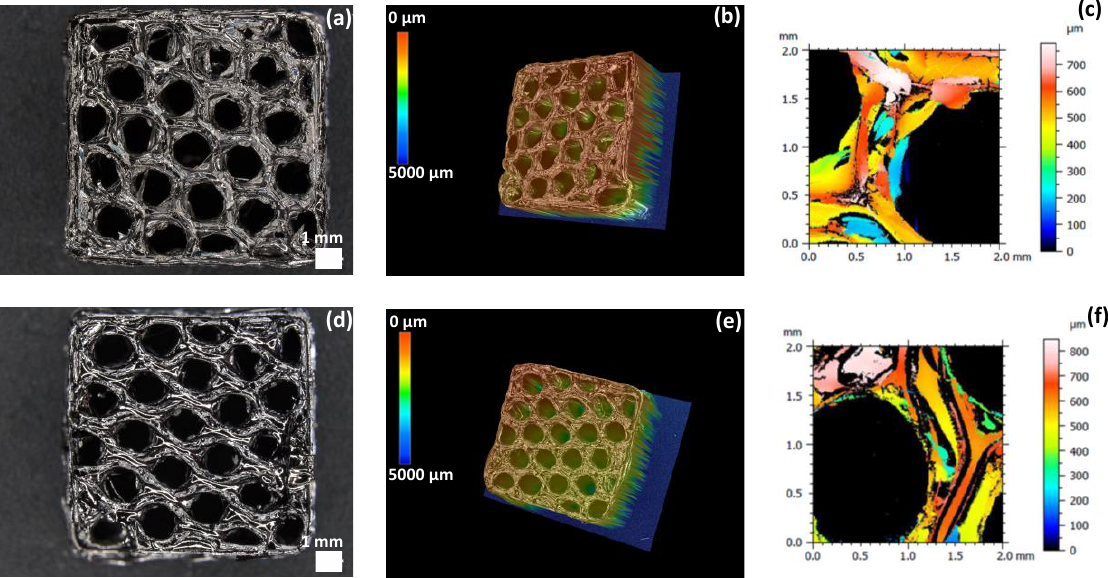
Figure 8. ( a , b ) 3D images of SiCN square ceramic lattice. ( c ) Roughness profile of a wall of 3D SiCN. ( d , e ) 3D images of SiC square ceramic lattice. ( f ) Roughness profile of a wall of 3D SiC. Table 4. Surface roughness of ceramics.